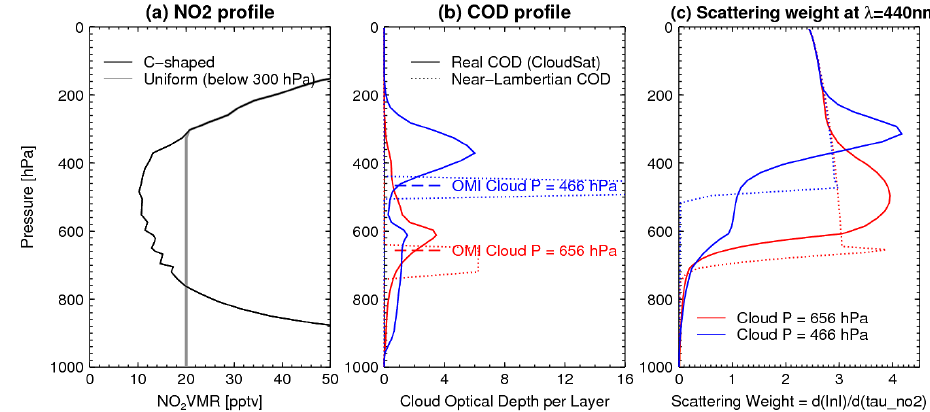
Figure 2. Experimental settings to simulate OMI above-cloud NO 2 VCD observations: (a) NO 2 profiles used in the AMF calculations, (b) cloud optical depth (COD) profiles used in the radiative transfer calculations, and (c) scattering weight profiles from the radiative transfer calculations corresponding to COD profiles in (b) . See text for more